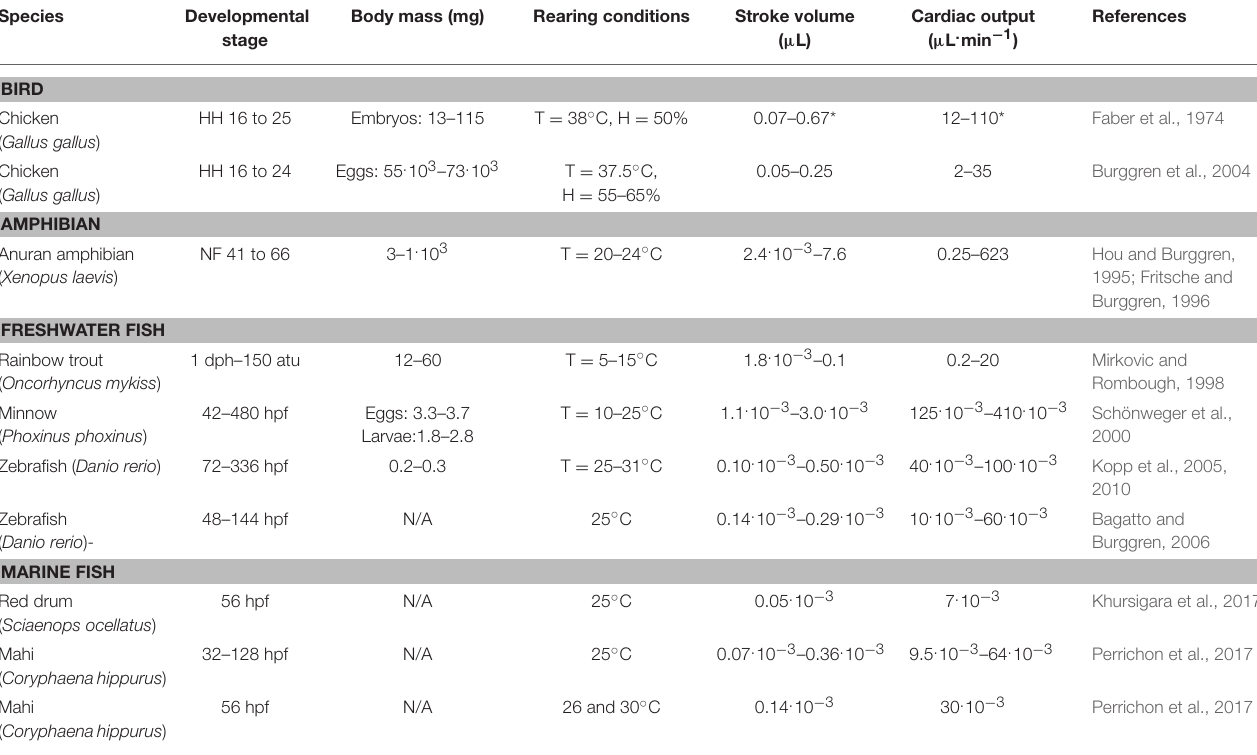
TABLE 4 | Representative cardiovascular research in vertebrate embryos and larvae reporting stroke volume and cardiac output derived from prolate spheroid heart modeling.